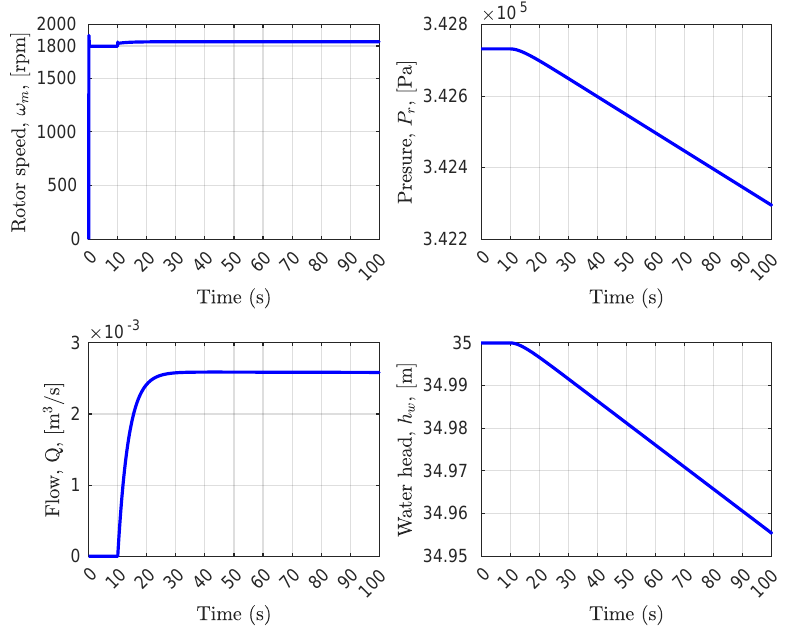
Figure 4. Second scenario: operation of the hydro turbine system, i.e., s = 1. The initial conditions are Q ( 0 ) = 0.0 ( m 3 / s ) , P r ( 0 ) = 3.4275 10 5 ( Pa ) , and h w = 35 ( m ) , which is the maximum capacity × of the penstock and the upper reservoir system.